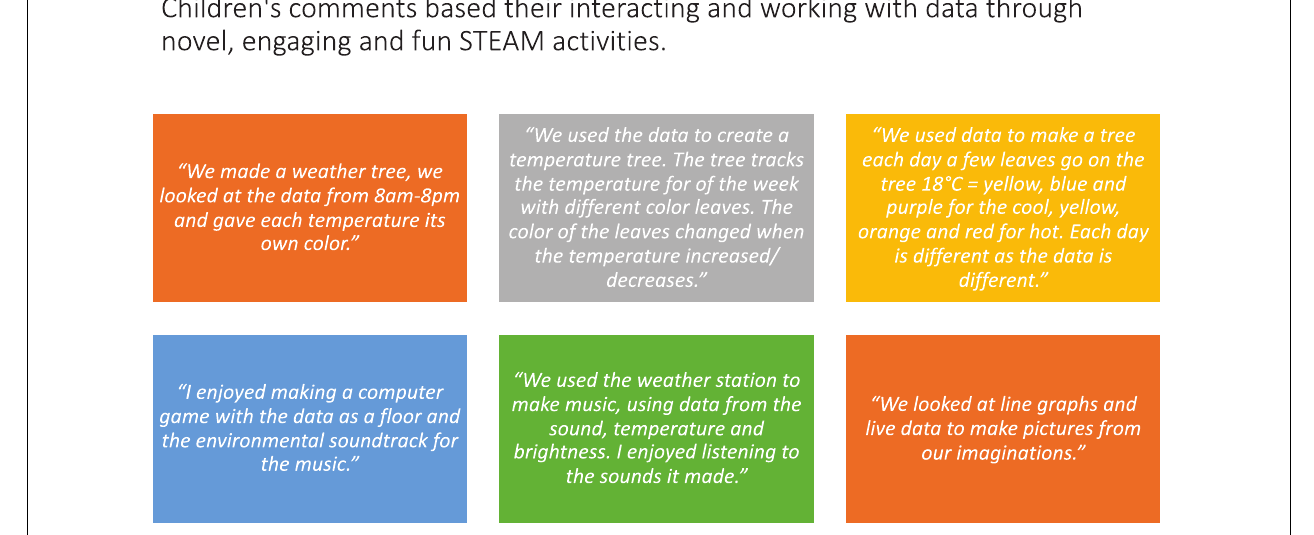
FIGURE 11 | Children’s comments based their interactions with and working with data through novel, engaging and fun STEAM activities.